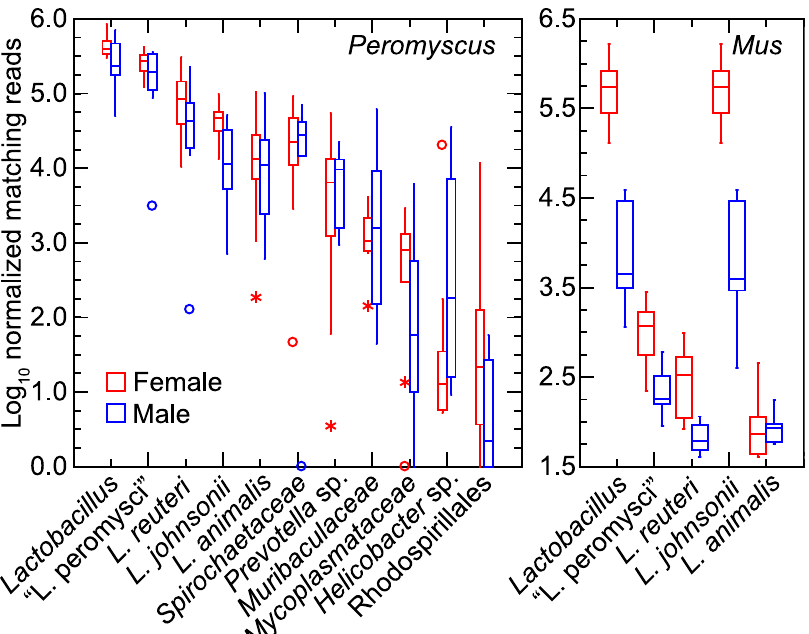
Fig 9. Box-whisker plots of log-transformed normalized reads of gut metagenomes of P . leucopus (left panel) and M . musculus (right panel) that mapped to chromosomes of Lactobacillus spp. or other bacteria by host species and grouped by sex. The references to which reads were mapped were complete chromosomes or partial chromosomes of organisms listed in Table 1. “ Lactobacillus ” in the first position of each panel were the cumulative reads for the four individual Lactobacillus species in this analysis.